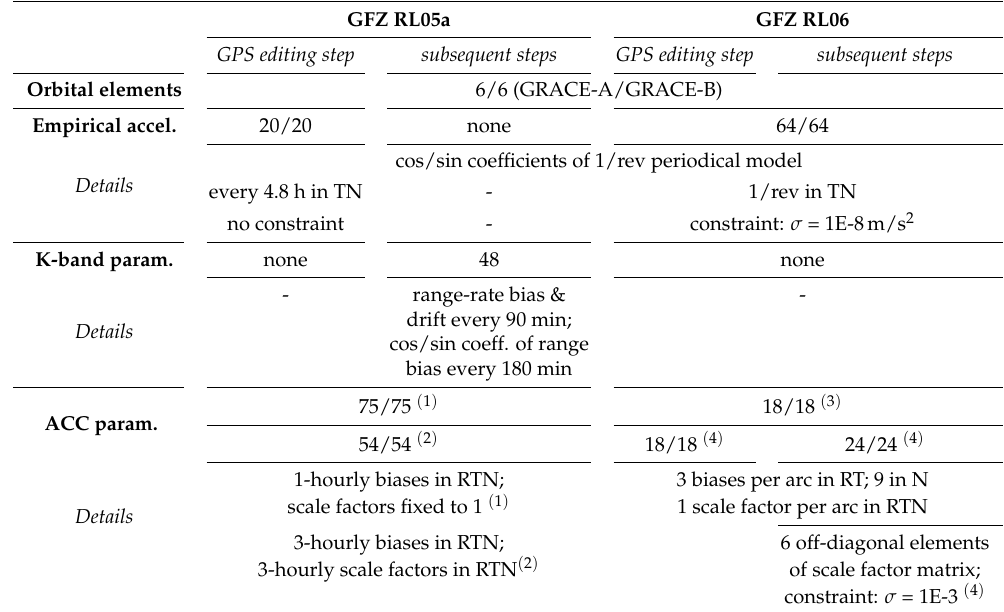
Table 3. Number and properties of GFZ RL05a and RL06 orbit and instrument parameters (numbers are per arc representative for the nominal arc length of 24 h). GFZ RL05a GFZ